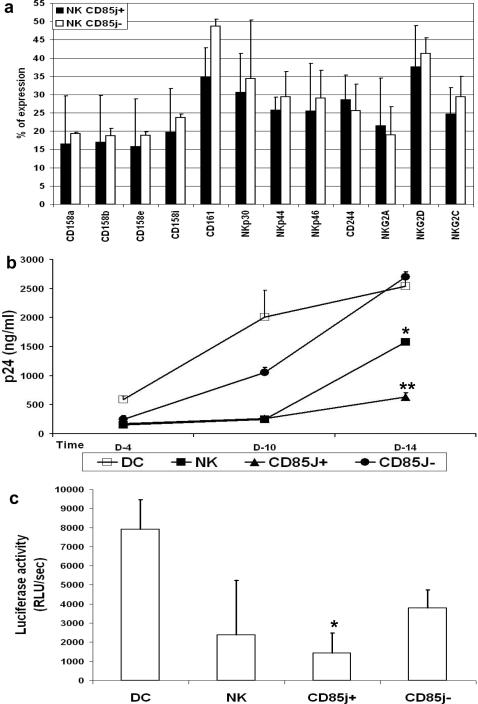
Suppression of HIV-1 replication in infected MDDC by the CD85j+ NK cell subset.(a) NKR expression on purified CD85j+ and CD85j− NN cell subsets. Results are expressed as percentage of receptor expression in the given subset+SE. (b) MDDC were infected with HIV-1Bal and then cultured alone (DC) or incubated with total NK cells (NK) or with the CD85j+ or CD85j− NK cell subsets. HIV-1 replication was measured by p24 production at the indicated time points. Mean+SE of p24 levels in 8 independent experiments using cells from different donors. p24 levels in NK/MDDC cocultures were compared to those in MDDC cultures * p<0.02, **p<0.001. (b) MDDC were one-round infected with HIV-1/BaL pseudotypes and then cultured alone (DC) or incubated with total NK cells (NK) or with the CD85j+ or CD85j− NK cell subsets. Ninety-six hours later, cells were lysed and luciferase activities were measured. Results are expressed as means±SE of luciferase activity of 4 independent experiments. CD85j+ NK cells induced higher levels of inhibition than CD85j− NK cells. * p<0.05